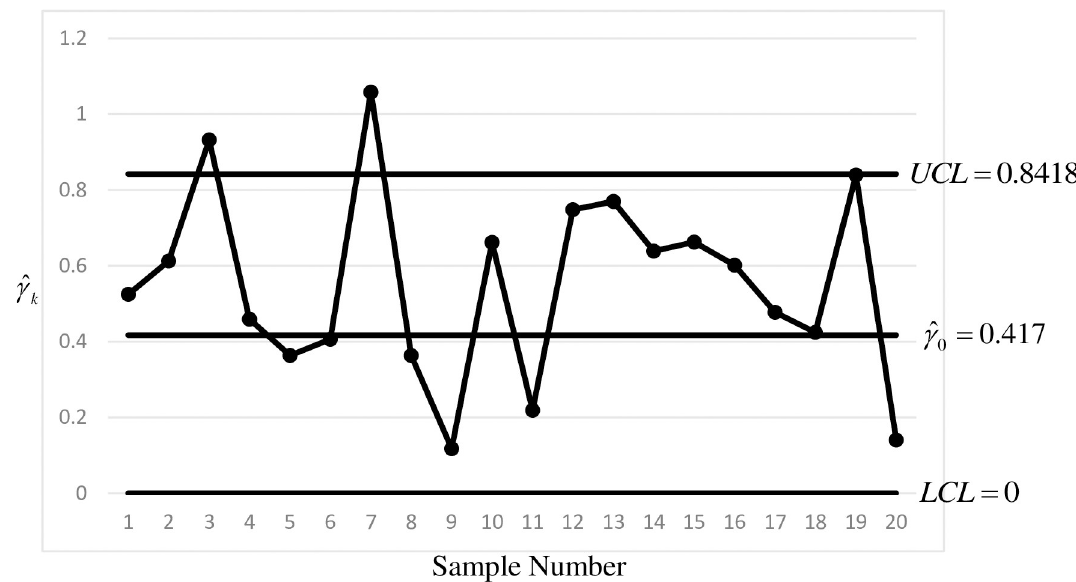
Fig 2. The γ sub-chart of the MRL -based side-sensitive synthetic- γ chart applied to the sintering process (Phase II).